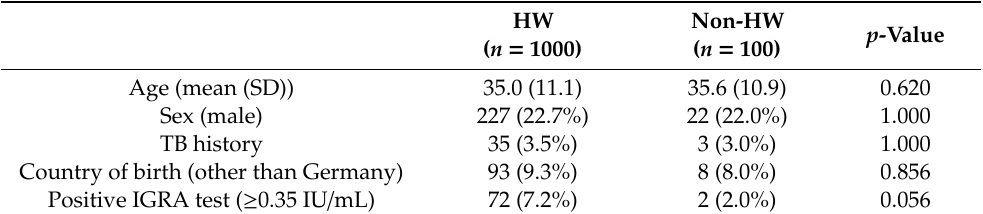
Table 2. Group comparison excluding subjects whose country of birth is a TB high-risk country after PS matching